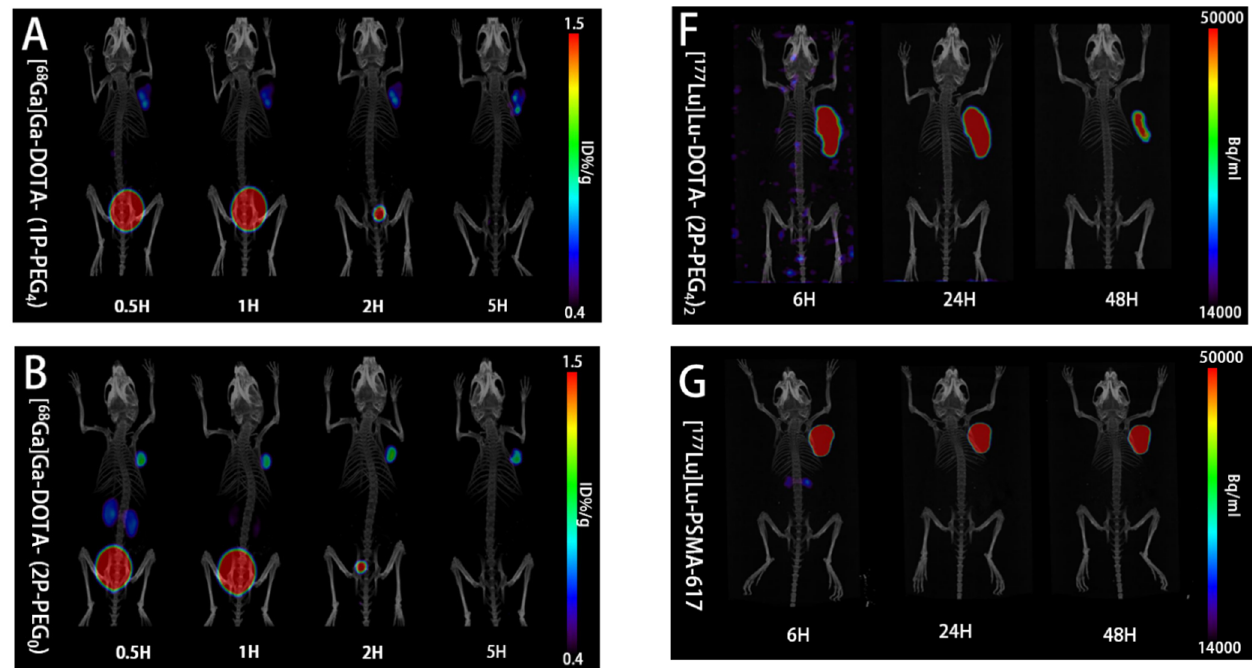
Figure 5. PC-3 PIP tumor-bearing mice were intravenously injected with 68 Ga-labeled DOTA-(1P- PEG 4 ), DOTA-(2P-PEG 0 ), DOTA-(2P-PEG 4 ), and DOTA-(2P-PEG 4 ) 2 at a dosage of 70 µCi through the caudal vein, and the corresponding tissue uptake values at 30 min ( A ), 60 min ( B ) and 120 min ( C ) were detected and presented as mean ± SD, n =